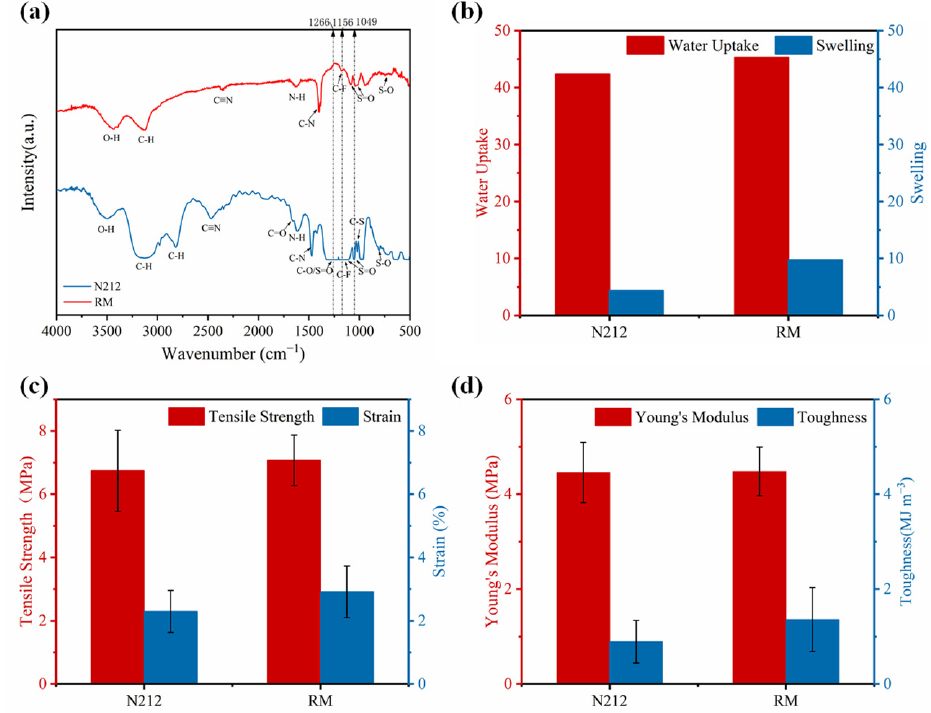
Figure 3. ( a ) FTIR spectrum of RM and N212, ( b ) swelling and water absorption of N212 and RM, ( c ) tensile strength and strain, ( d ) Young’s modulus and toughness of N212 and RM.